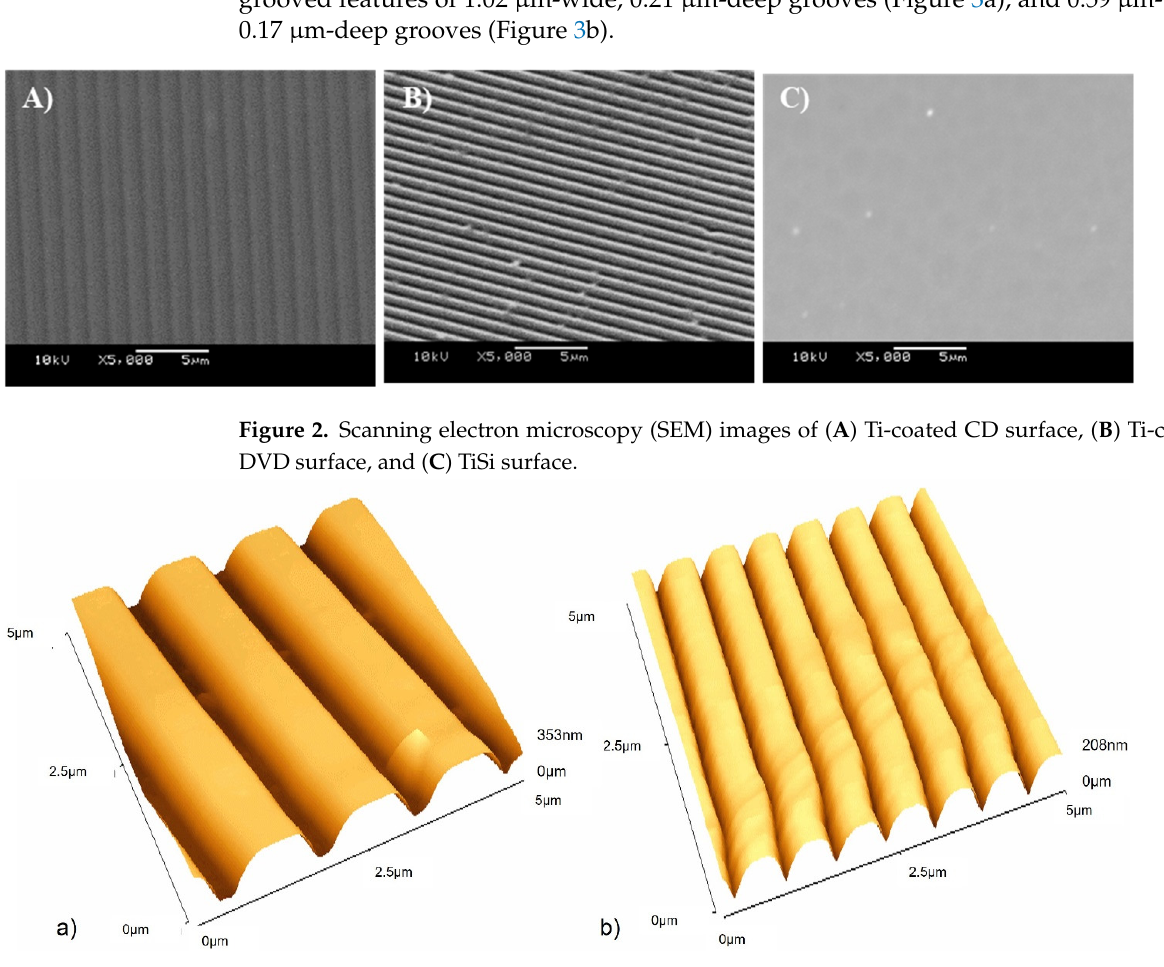
Figure 3. Atomic force microscopy (AFM) images of ( a ) Ti-coated CD surface and ( b ) Ti-coated DVD DVD surface.